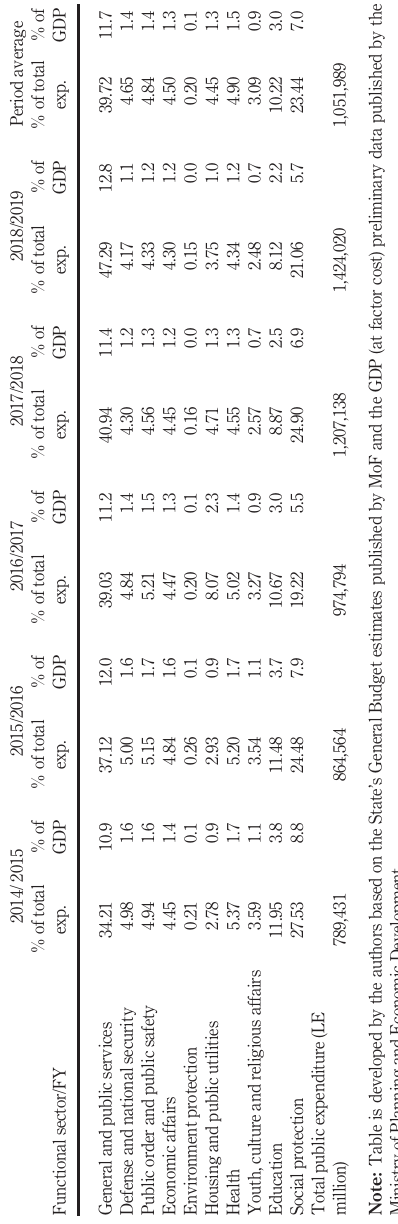
Table A3. Egypt ’ s public expenditure by functional classification: Relative shares in total public expenditure and in